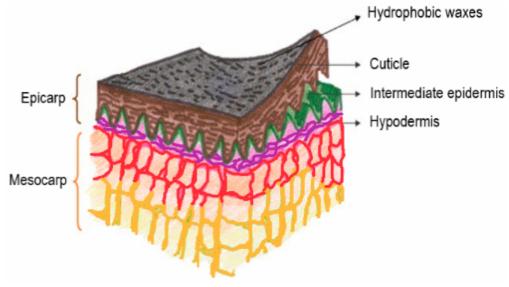
Figure 2. Different layers of the grape skin